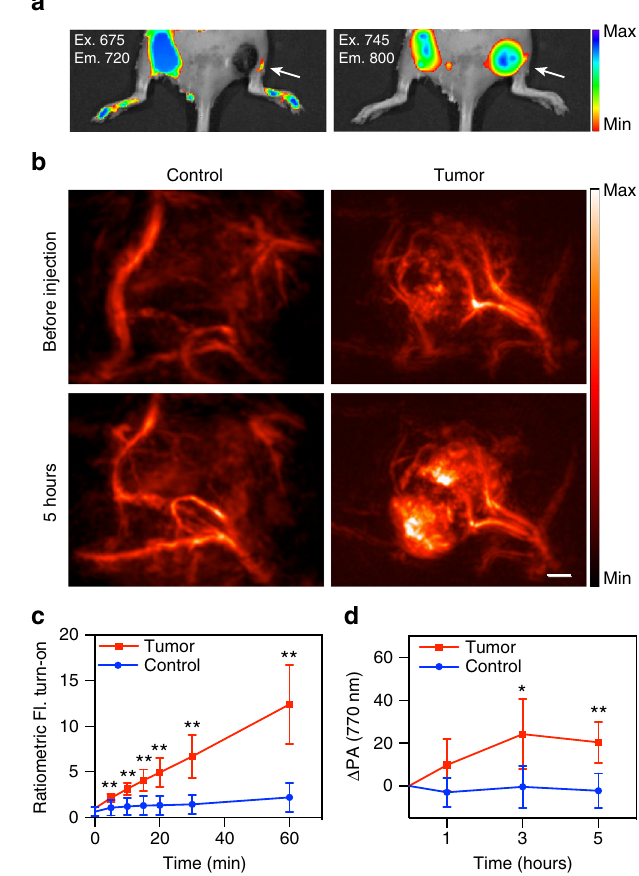
Fig. 6 In vivo imaging of tumor hypoxia with HyP-1. a Fluorescence (IVIS spectrum) images acquired of a 4T1 tumor-bearing mouse 1 h following intratumoral injection (50 μ L, 100 μ M) of HyP-1. Images were acquired using 675/720nm and 745/800nm fi lter sets. Arrows indicate tumor. b PA images (770 nm) of the tumor-bearing and control fl ank before and 5 h following injection of HyP-1 (50 μ L, 0.3 mg/kg). Scale bar represents 2 mm. c Time-dependent ratiometric fl uorescence increase of tumor-bearing and control fl anks ( n = 5). d Time-dependent increase of PA signal of tumor- bearing and control fl anks ( n = 5). Results with error bars are represented by mean ± SD. * p < 0.05, ** p < 0.01